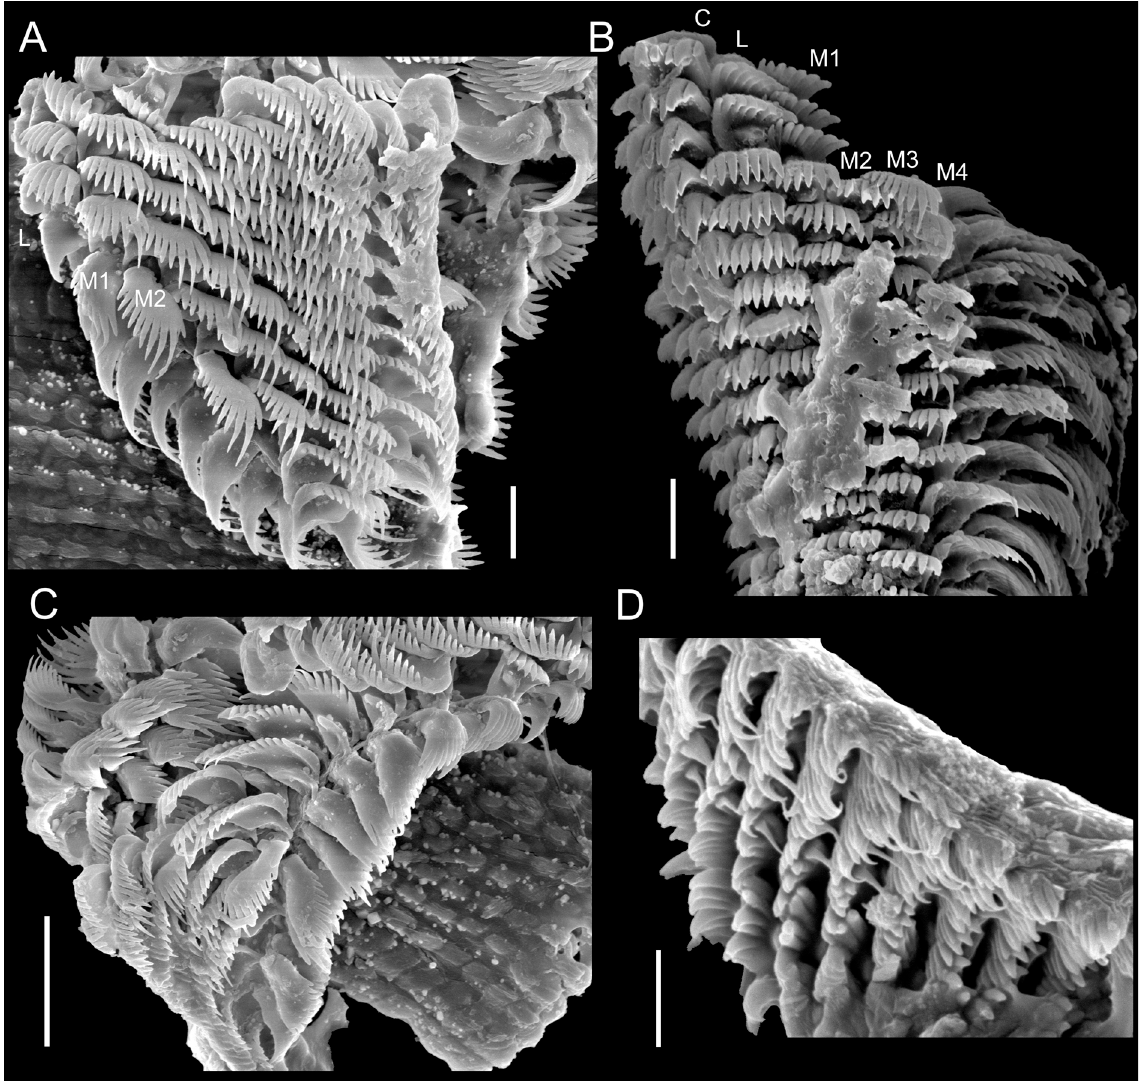
Fig. 6. Cheirodonta dupliniana (Olsson, 1916) comb. nov. A–D . Radula (USNM 1438722). Scale bars: A–B, D = 5 µm; C = 10